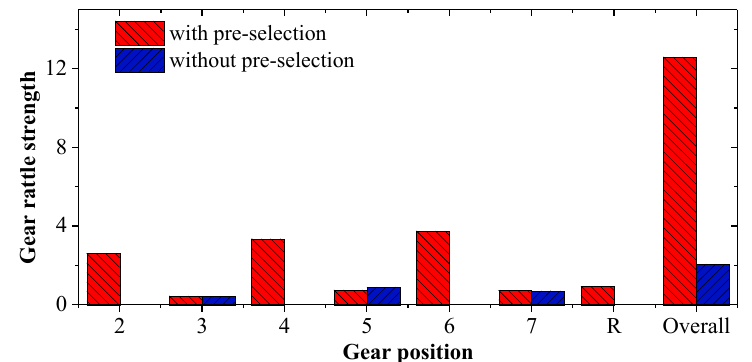
Figure 16. Gear rattling strength: (a) 1st gear; (b) 1st gear pre-selection 4th